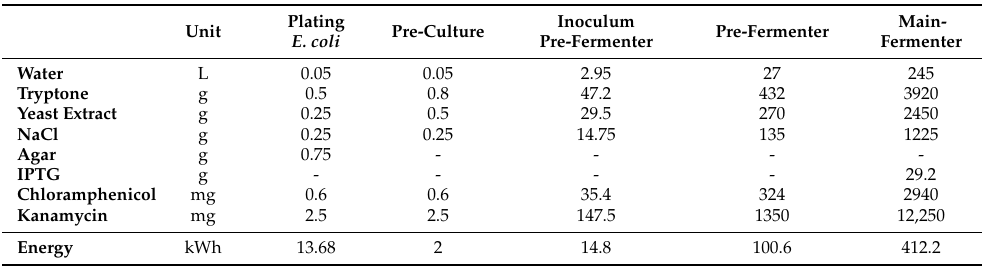
Table A1. Detailed list of all chemicals and energy quantities required during seed-train and enzyme